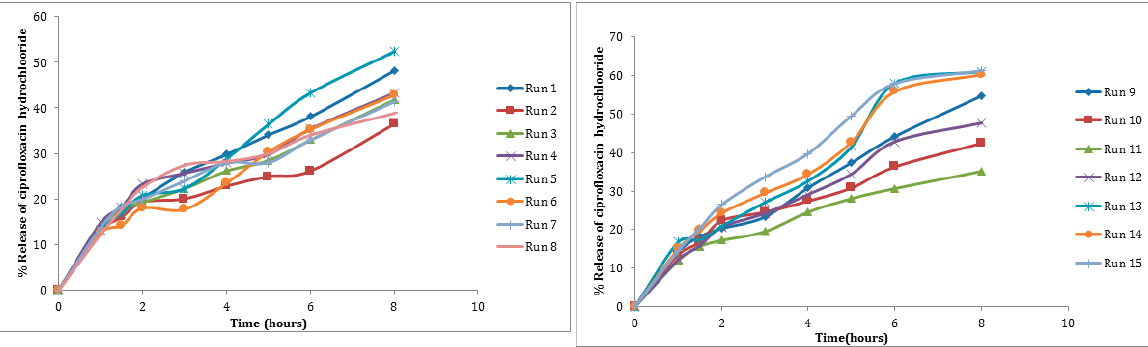
Figure 9. Antibacterial activity of CHCl soln. and CHCl-loaded CS-NPs. Table 11. MIC values for two bacterial strains.